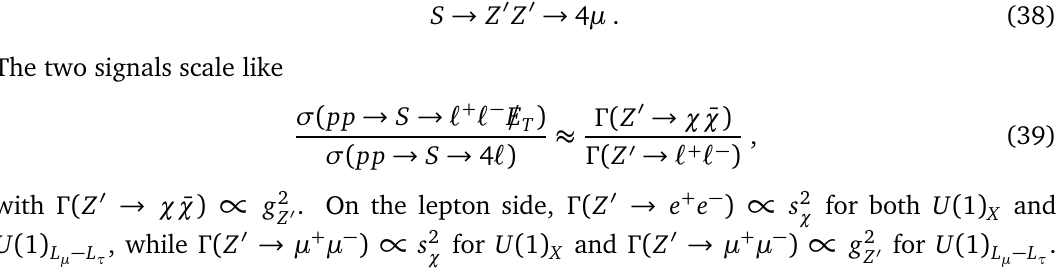
Figure 10: The two-dimensional distributions of the leading and second jet p signal (left; same benchmark point as plotted above) and background